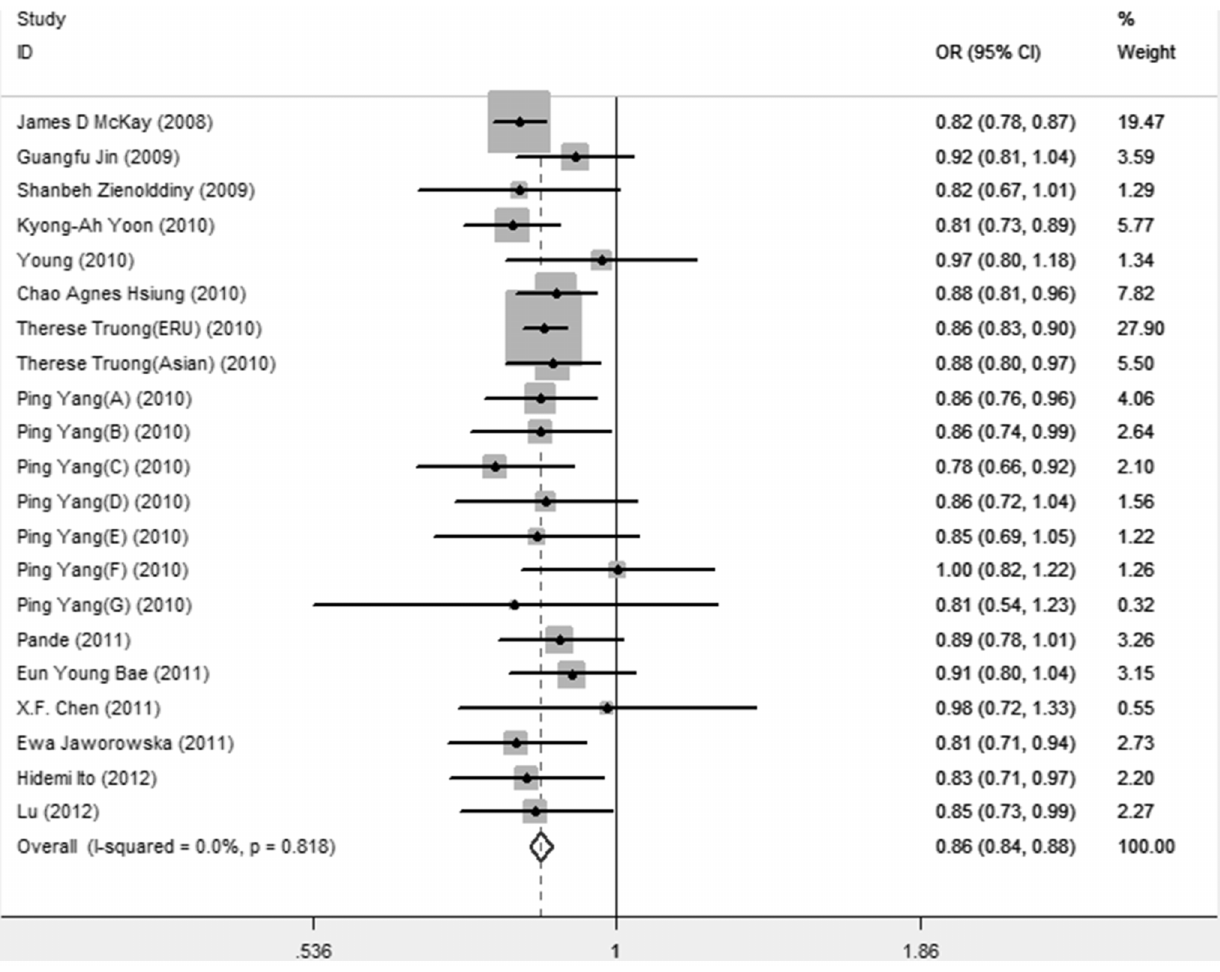
Table 4. Pooled OR with 95% CI for the association between rs402710 and lung cancer risk in the meta-analysis.